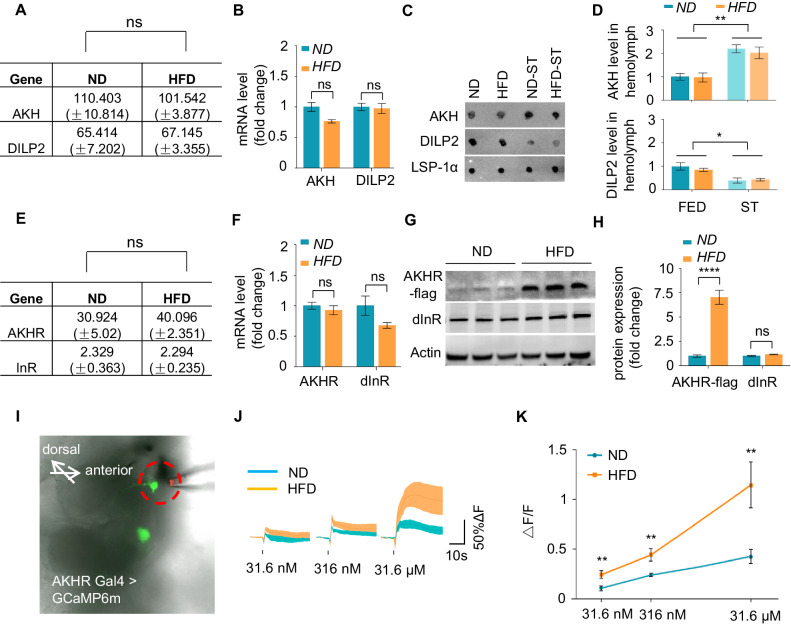
HFD increases neuronal AKHR protein.(A–B) AKH and DILP2 mRNA levels of wild-type virgin female flies fed with ND or HFD. The fly heads and associated tissues were collected and subjected to RNAseq (A) or quantitative RT-PCR (B) (n = 3 biological replicates, each containing 25 flies). (C–D) AKH and DILP2 protein levels in the hemolymph of wild-type virgin female flies fed with ND or HFD and assayed under both fed and starved conditions (n = 3 biological replicates, each containing 30 flies). Hemolymph samples were collected from the flies and AKH and DILP2 protein levels were analyzed by dot blot with AKH and DILP2 antibodies (C), and the quantification was shown in (D). (E–F) AKHR and InR mRNA levels were analyzed similar to A-B (n = 3 biological replicates, each containing 25 flies). (G–H) AKHR and dInR protein levels of fly heads were analyzed by western blot (n = 3 biological replicates, each containing 25 flies). Note that AKHR-flag knock-in flies were generated by inserting FLAG sequence into the C terminal of AKHR gene via CRISPR/cas9 mediated gene editing. Antibodies against FLAG and dInR were used in the western blot. (I) Schematic diagram of the ex vivo calcium imaging. Green signals indicate AKHR+ neurons expressing GCaMP6 (AKHR:BD/+; nSyb:AD/UAS-GCaMP6m). Dotted red circle indicates the position of the pipette delivering synthetic AKH. (J–K) Representative traces (J) and quantification (K) of peak calcium transients of AKHR+ neurons upon AKH administration (n = 7–10). ns, p>0.05; *p<0.05; ***p<0.001. Student’s t-test and one-way ANOVA followed by post hoc test with Bonferroni correction were used for pair-wise and multiple comparisons, respectively.